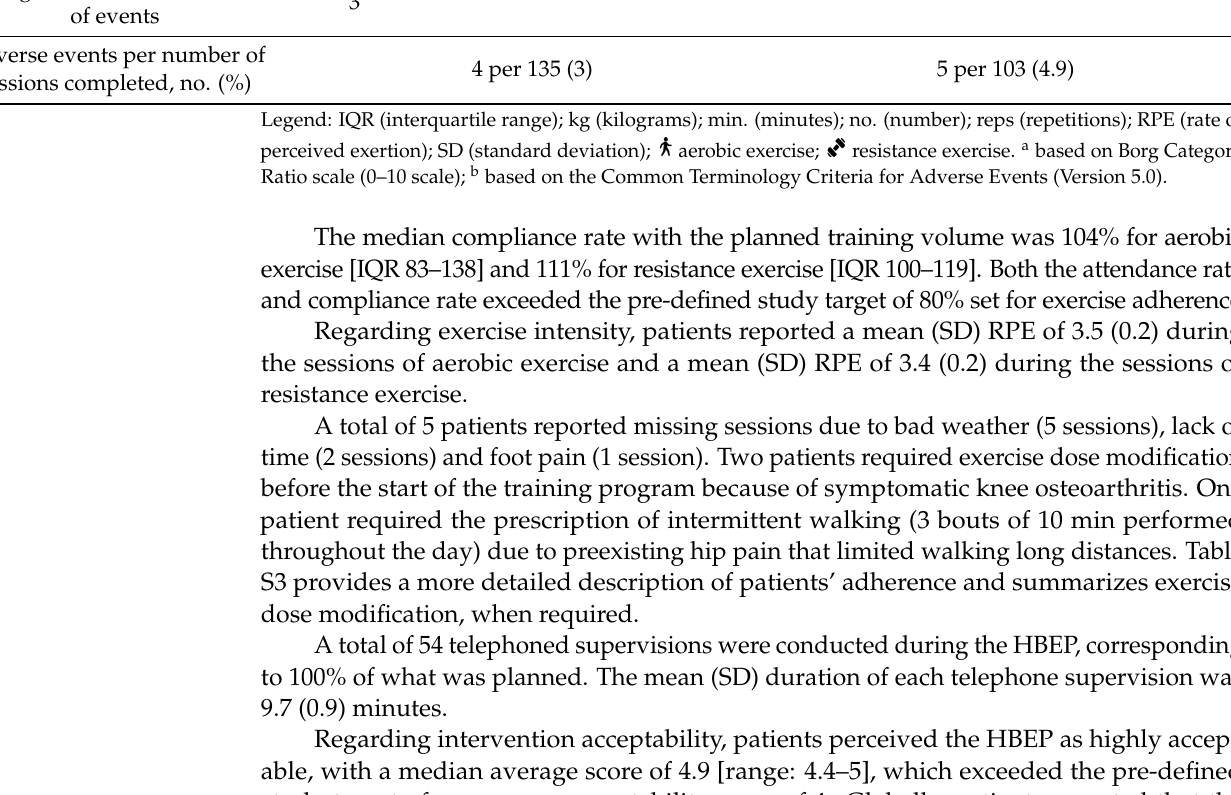
Table 2. Exercise adherence and adverse events.